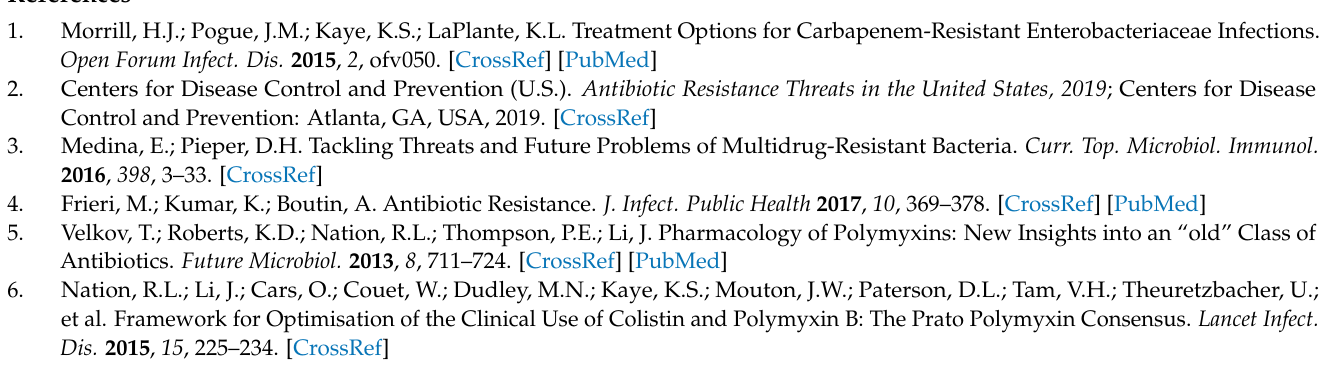
Figure S4: Correlation between AUC obs and AUC pred . AUC pred was estimated from LSS C 6 (Chen et al. [21]), LSS C 4 , C 6 (Chen et al. [21]), LSS C 1.5 , C 4 , C 6 , C 8 (Wang et al. [22]), and LSS C 1 , C 1.5 , C 4 , C 8 (Wang et al. [22]); Figure S5: Bland–Altman plots of the relative difference between AUC pred and AUC obs versus the average of AUC pred and AUC obs . AUC pred was estimated from LSS C 6 (Chen et al. [21]), LSS C 4 , C 6 (Chen et al. [21]), LSS C 1.5 , C 4 , C 6 , C 8 (Wang et al. [22]), and LSS C 1 , C 1.5 , C 4 , C 8 (Wang et al. [22]); Figure S6: Goodness-of-fit plots for the final population pharmacokinetic model. (A) Conditional weighted residuals versus time (CWRES vs. IVAR); (B) conditional weighted residuals versus population predicted concentrations (CWRES vs. PRED); (C) observed versus individual predicted concentrations (DV vs. IPRED); (D) observed versus population predicted concentrations (DV vs. PRED); Figure S7: Prediction-corrected visual predictive check of the final model. Red lines represent the 5th, 50th, and 95th percentiles of the observed concentration; the shaded areas represent the 90% confidence intervals of the 5th, 50th, and 95th percentiles of simulated concentrations, respectively; the dots represent the observed data; DV, PMB observed concentration; IVAR, time after the last dose; Table S1: PMB LSSs developed by multiple regression analysis from our center (n = 20); Table S2: Predictive performance of selected PMB LSSs developed by MLR analysis from our center; Table S3: A summary of the published PMB LSS studies; Table S4: The predictive performance of MLR-based PMB LSSs available in the literature for estimation of PMB AUC pred in patients with MDR Gram-negative bacteria infection treated with PMB; Table S5: Population PK parameter estimates in the final model and bootstrap; Table S6: Individual pharmacokinetic parameter estimates; Table S7: The predictive performance of the validated LSSs from the published literature following the simulation under infusion time of 0.5, 1.5, 2, and 2.5 h; Table S8: The predictive performance of the LSSs (C 0 , C 1 ) that were established by our center following the sampling time error of 0, ± 5, ± 10, ± 15, ± 20, ± 25, and ± 30